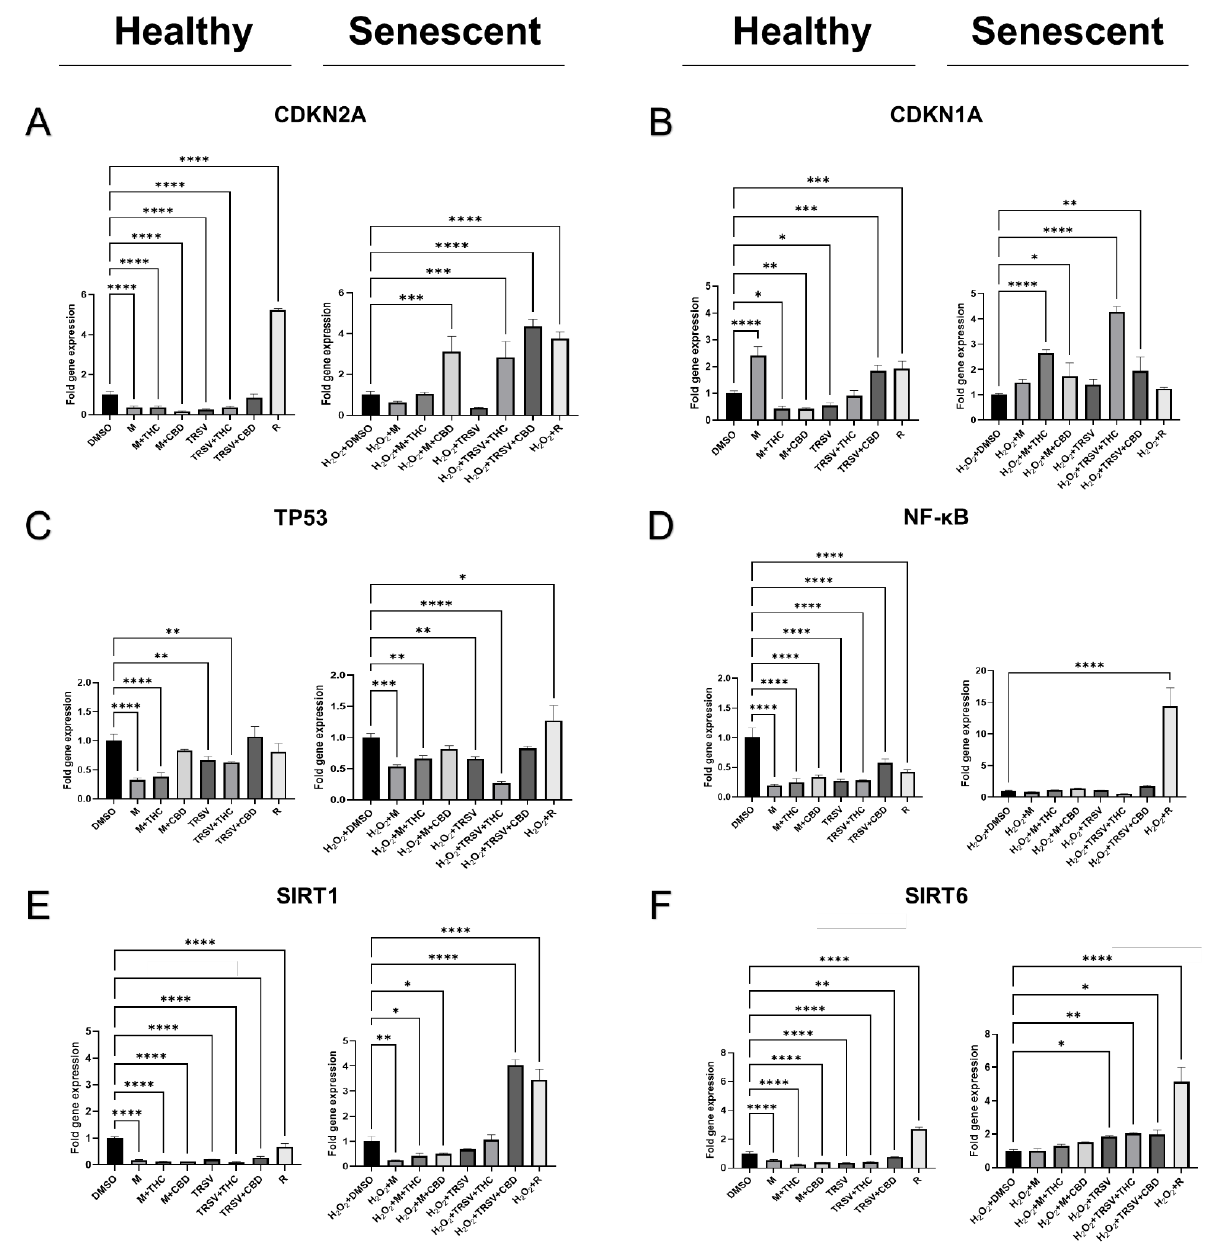
Figure 6. The expression of cellular checkpoint regulators in CCD-1064Sk (p.11) fibroblasts treated with nutrient signaling regulators combined with cannabinoids. Changes of mRNA expression as measured by RT-qPCR for ( A ) CDKN2A (p16), ( B ) CDKN1A (p21), ( C ) TP53 , ( D ) NF- κB , ( E ) SIRT1 , and ( F ) SIRT6 in healthy and senescent fibroblasts. Data were analyzed with a one-way ANOVA test followed by a Dunnett post hoc test compared to the vehicle. Bars represent mean ± SD. Significance is indicated within the figures using the following scale: * p < 0.05, ** p < 0.01, *** p < 0.001, **** p < 0.0001. CBD, cannabidiol; DMSO, dimethyl sulfoxide (vehicle), M, metformin; R, rapamycin; THC, Δ -9-tetrahydrocannabinol; TRSV, triacetylresveratrol.